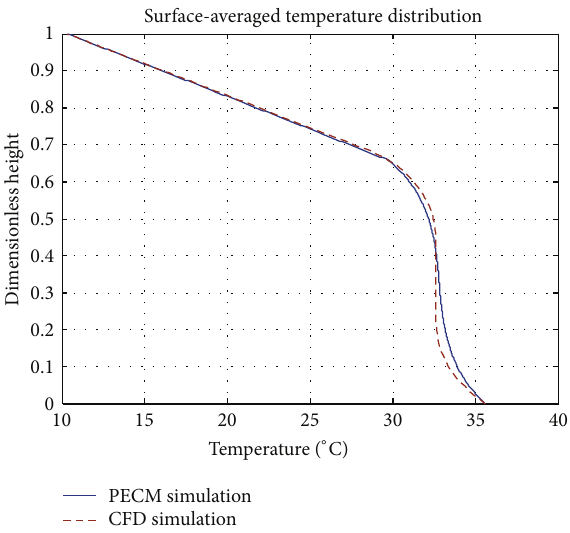
Figure 12: ECM and CFD predicted heat flux profiles along the CRGT cooled wall.